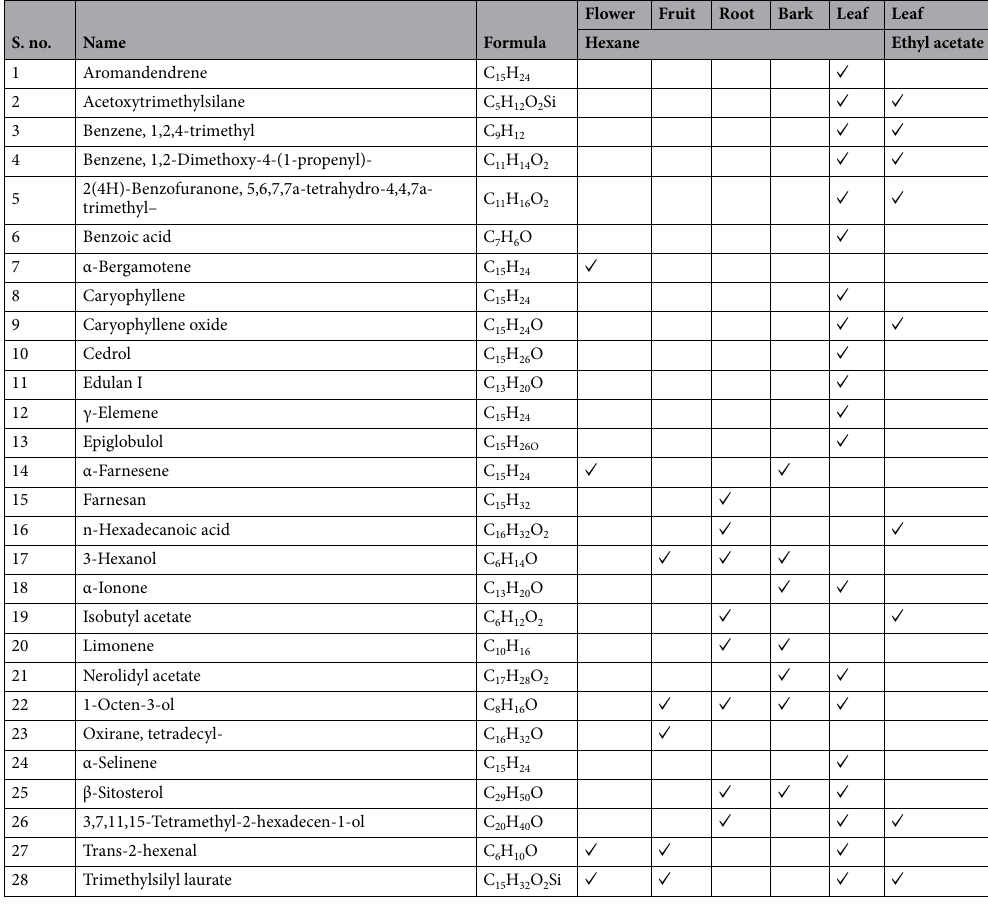
Table 1. Major bioactive constituents present in Gmelina arborea as characterized by GC–MS analysis rendering the antimicrobial and antioxidant